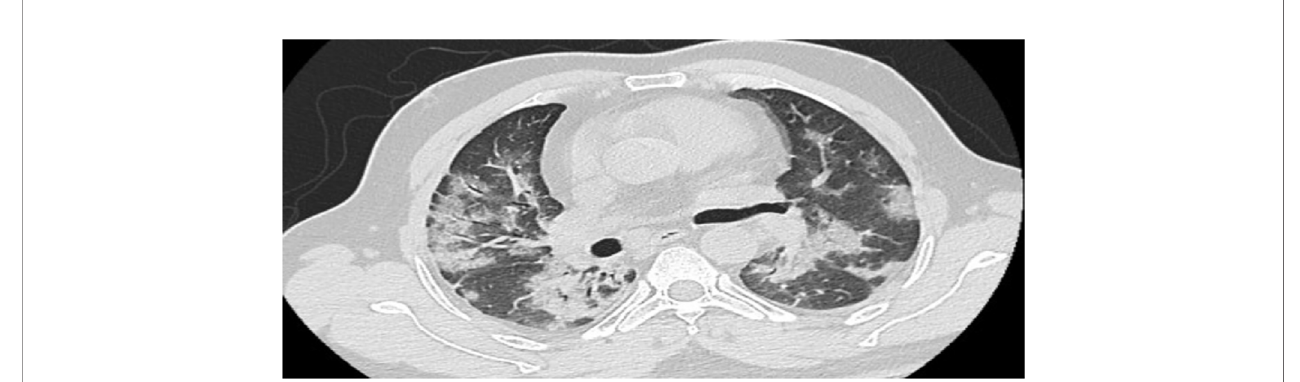
FIGURE 2 | Bilateral multilobar ground-glass opaci fi cation and consolidations, preferentially peripheral and subpleural.